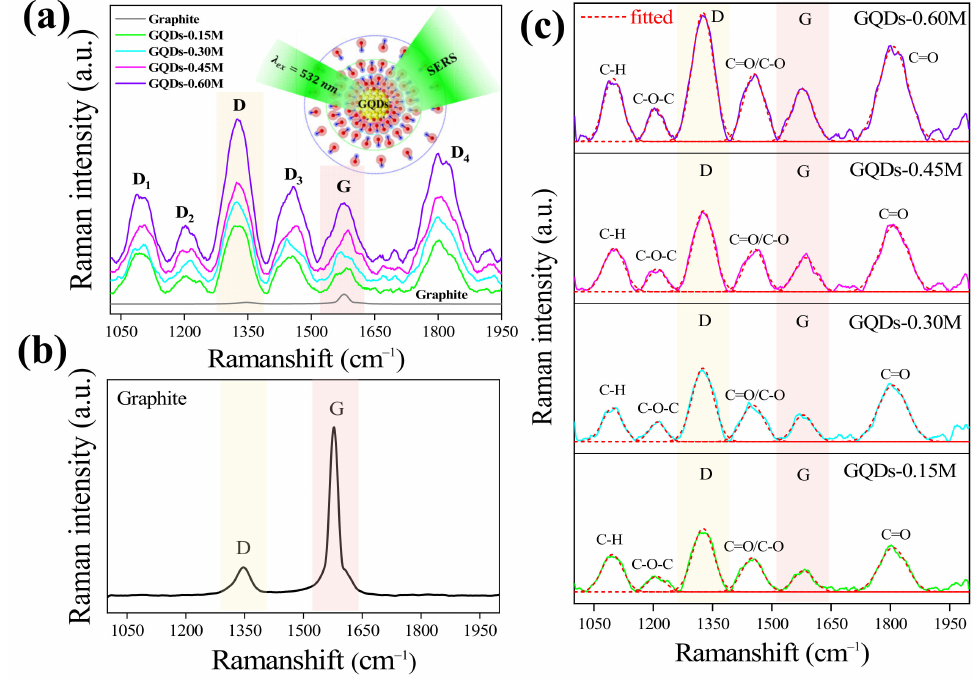
Figure 6. ( a ) Raman spectra of GQDs at various electrolyte concentrations with ( b ) Raman spectrum of the normal graphite for comparison and ( c ) fitted Raman spectra of GQDs with a Gaussian function to obtain the peak